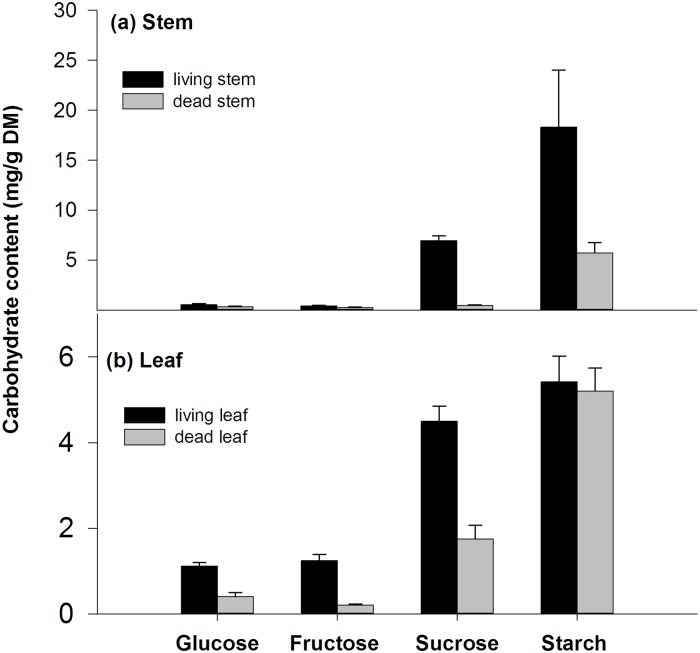
Carbohydrate content (mg·g-1 DM) in living stems and dead stems (from plants harvested at day 30 submerged at 30°C) and in living leaves and dead leaves (from plants harvested at day 30 submerged at 30°C).Points = mean + SE, n = 5. *, p < 0.05, ns, p > 0.05.